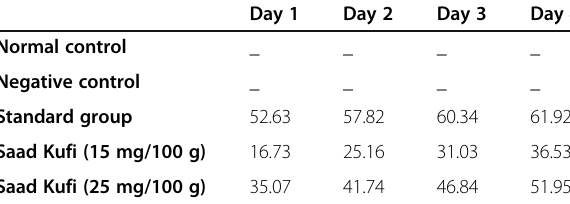
Table 2 Percent inhibition in systolic blood pressure